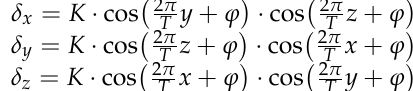
; and M is the number of microscopic distortions.